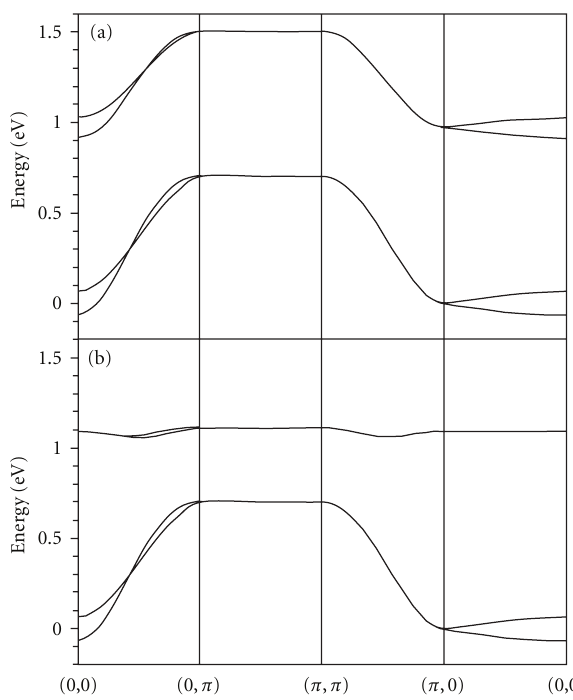
Figure 29: (a) The dispersion of the V d xy bands calculated from the = 1 . 7eV, t = extended TB model with four hopping terms t VO VO L R = 0 . 6eV, and t = 0 . 032eV (see text). (b) The same 1 . 0eV, t O VV L O L = 0 . 8eV, t = as (a) but with additional hopping terms t O O R O R R O L = 0 . 025eV which suppress the dispersion of the 0 . 4eV, and t (cid:2) VO R upper pair of the bands